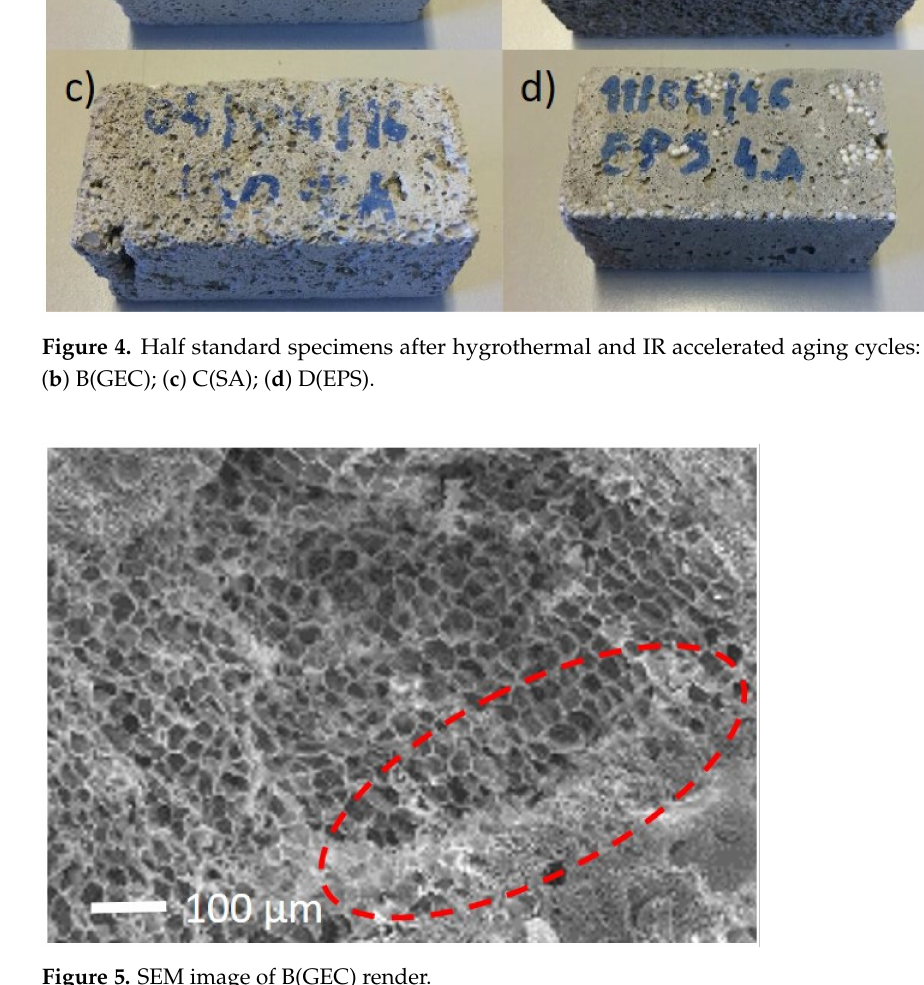
Figure 5. SEM image of B(GEC)